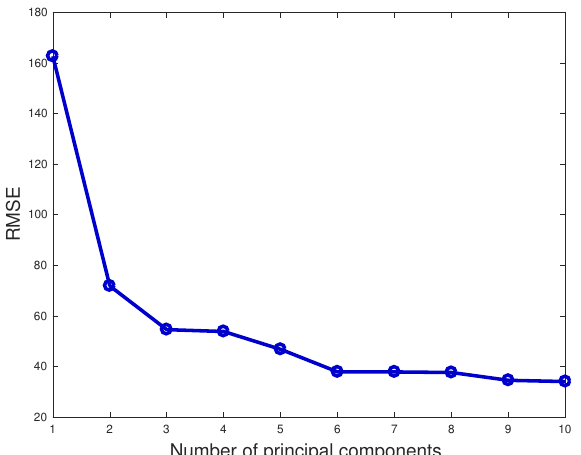
Figure 9. Average RMSE as a function of the number of principal components included in the